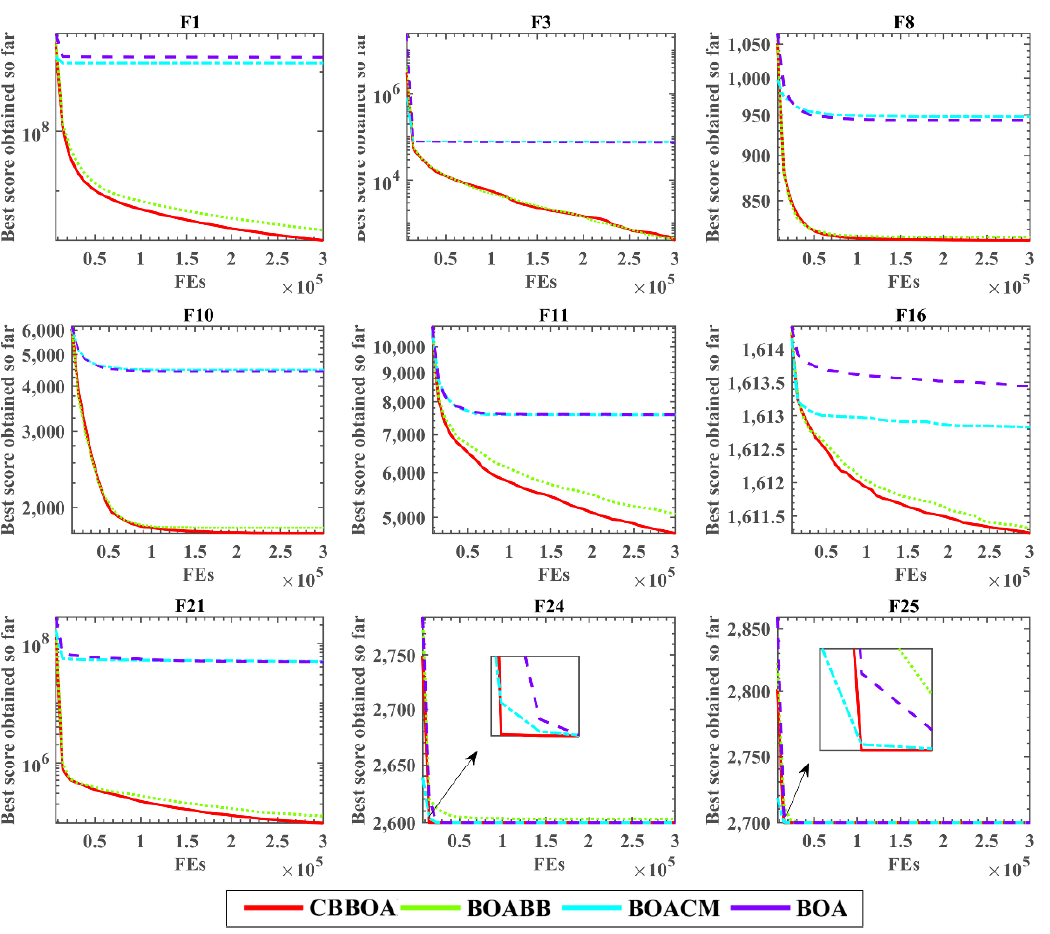
Figure 4. Convergence curves of CBBOA and its variants (First row: F1, F3, F8; second row: F10, F11, F16; third row: F21, F24, F25).